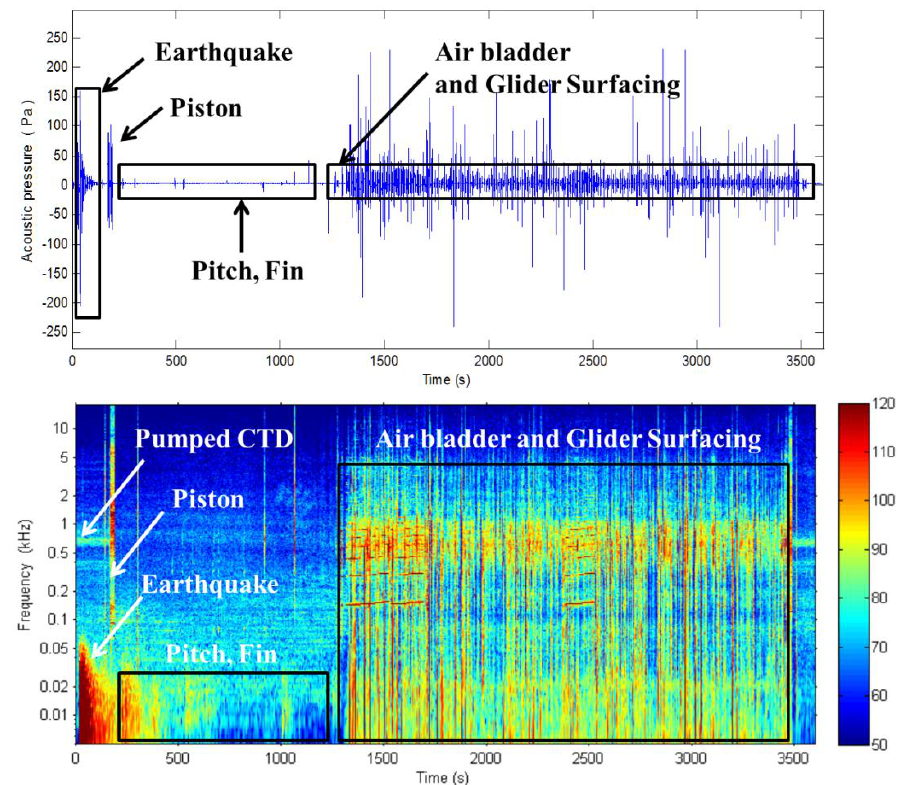
Figure 8. Spectrogram of earthquake underwater sound recording (started at 05:29:35 UTC).